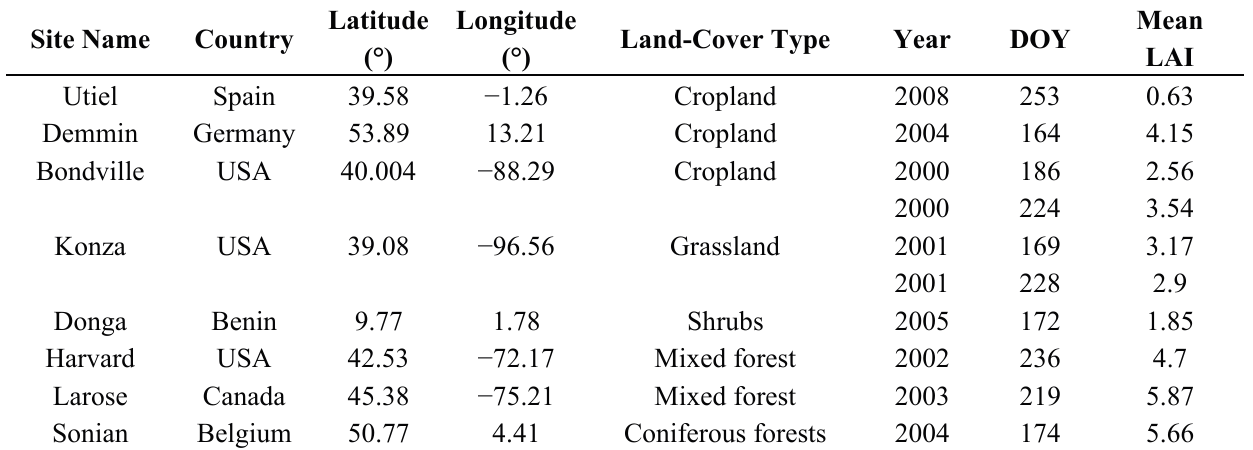
Table 2. Characteristics of the selected